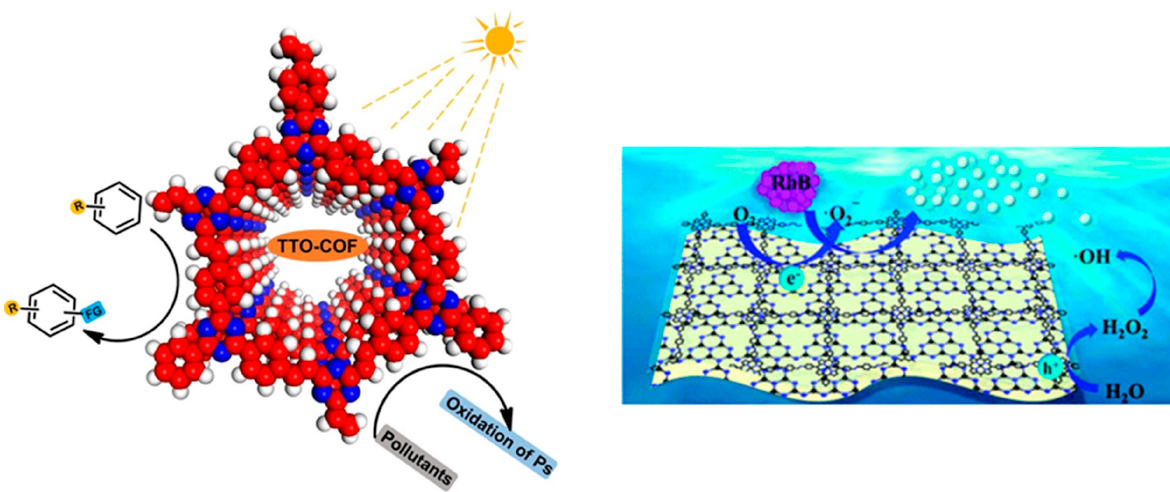
Figure 5. Illustration of photodegradation applications of COFs. Adapted with permission from references [132] copyright 2020 Elsevier and [133] copyright 2019 The Royal Chemical Society.